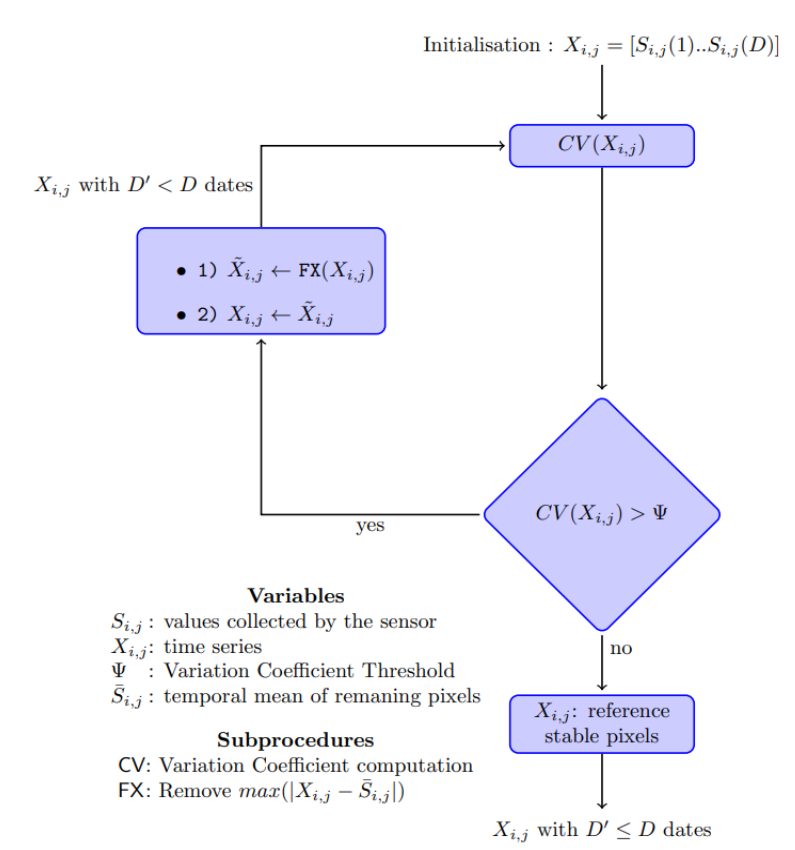
Figure 3. Candidate pixel selection within the